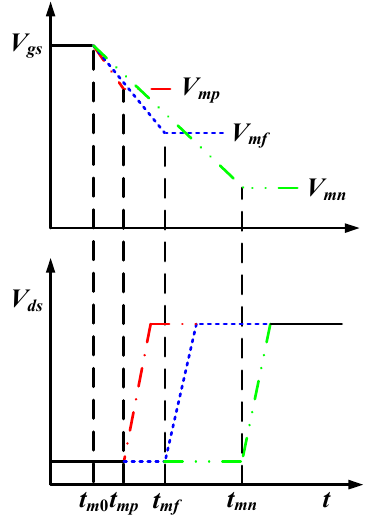
Figure 3. Turn-off waveform of V gs and V ds according to a variation of V m . In Figure 3, V mp , V mf , and V mn mean V m in positive V th shift, fresh state, and negative V th shift, respectively. In addition, t mp , t mf , and t mn indicate a time when V ds increases in positive V th shift, fresh state, and negative V th shift, respectively. t m0 is the point at which V gs begins to decrease to turn off the switch. Figure 3 indicates that the time at which V ds increases is faster as V m increases. Therefore, as V m increases, T doff decreases and vice ver- sa. T doff can be expressed as (8):